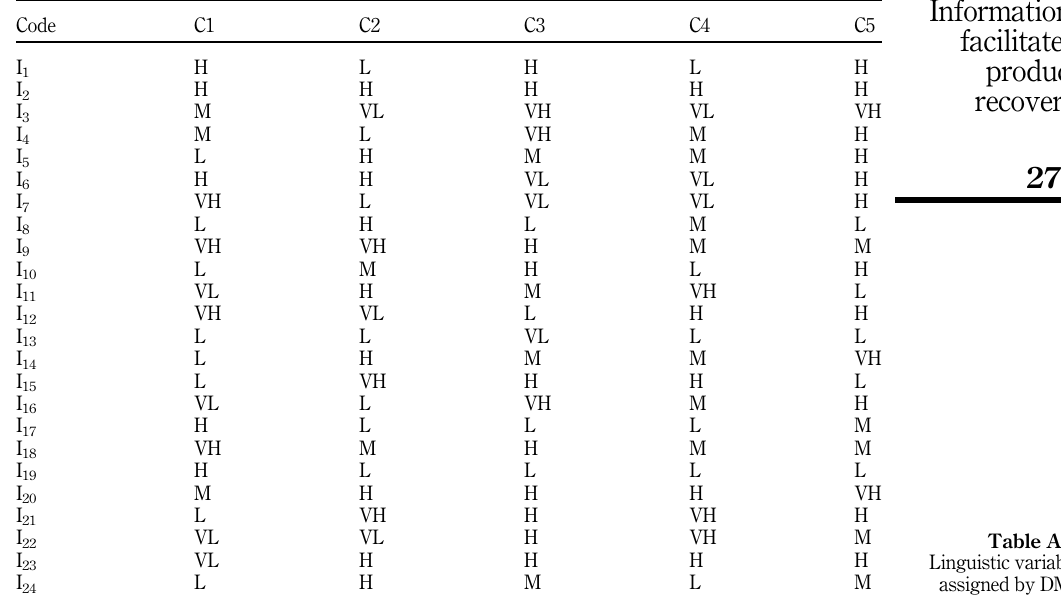
Table A7. Linguistic